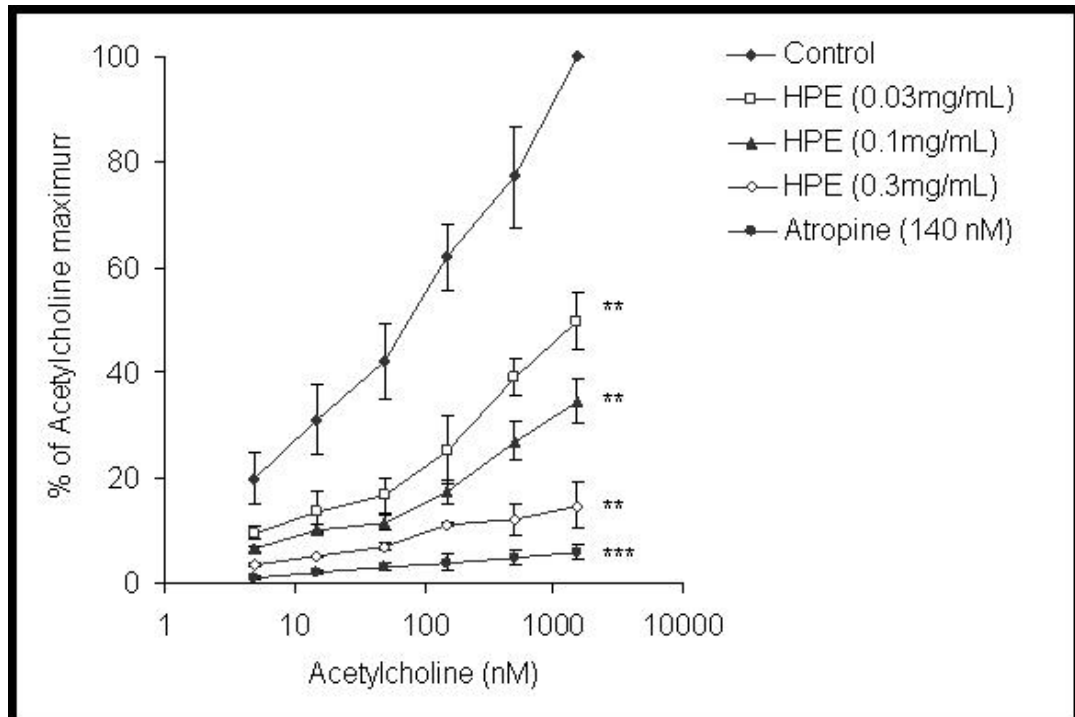
Figure 3. Comparison of dose-response curves of acetylcholine in absence and presence of the ethanol extract of Helichrysum plicatum (HPE) and atropine in isolated rat